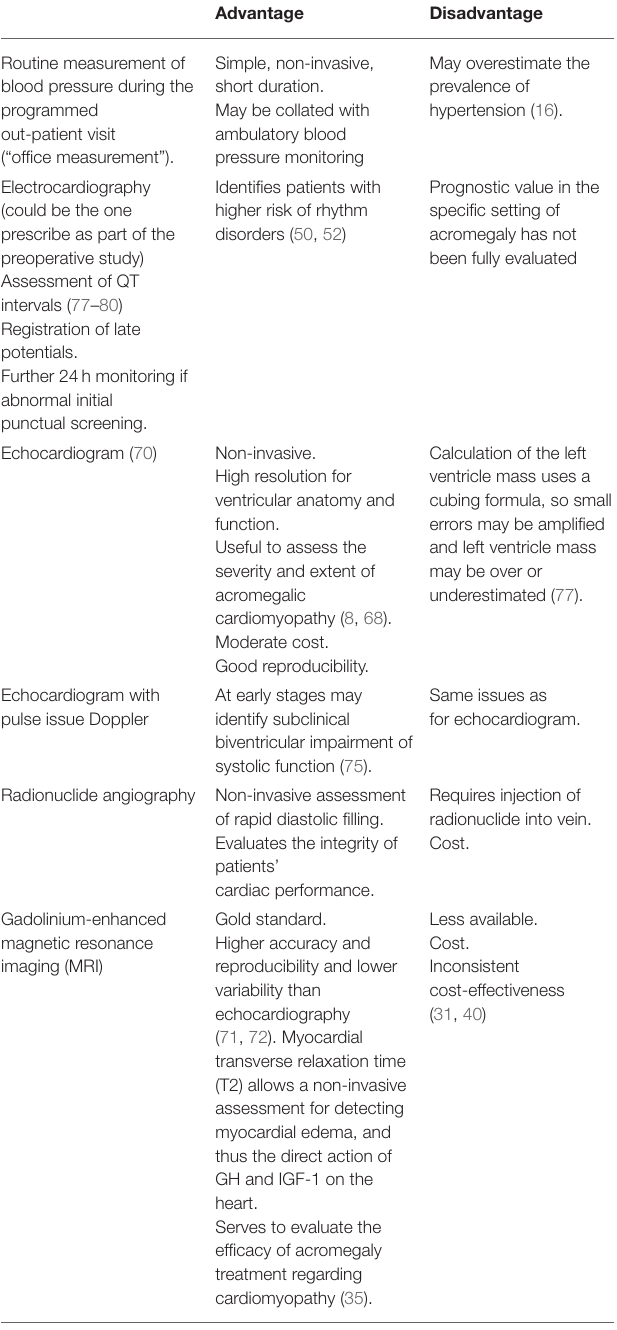
TABLE 2 | Possible screening methods for each of the potential cardiovascular comorbidities encountered in patients with acromegaly, describing their main pros and